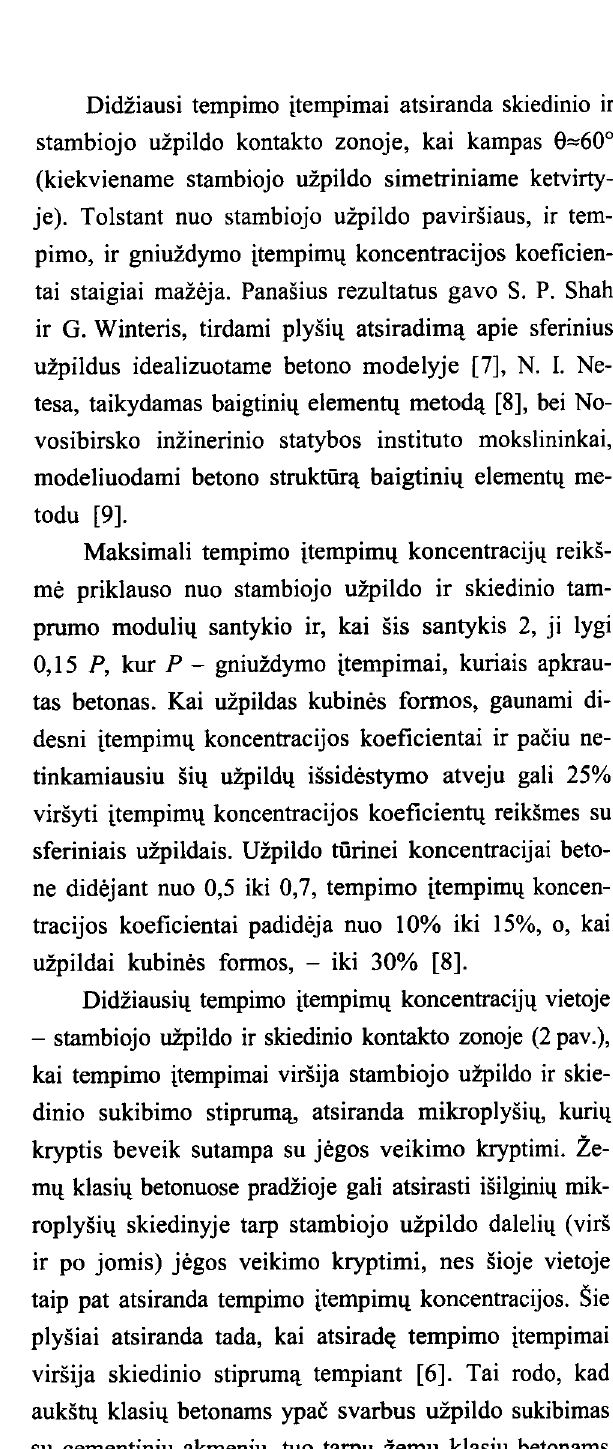
Fig 2. Distribution of stresses in the concrete near den se coarse